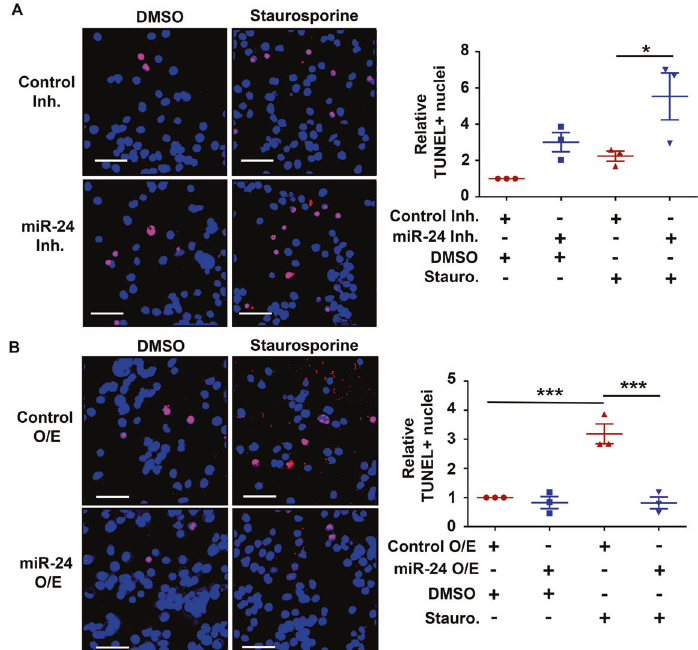
Fig. 6 miR-24-3p promotes intestinal epithelial cell survival. A , B SW480 cells transfected with either inhibitors or mimics in the presence or absence of staurosporine were fi xed and TUNEL stained. Magenta cells are TUNEL-positive and non-TUNEL-positive cell nuclei are labeled in blue. Three 250 × 250 µm fi elds were selected for quanti fi cation and are depicted in the graph. Three independent experiments. Mean ± SEM. Scale bars = 50 µm. * p < 0.05; *** p <